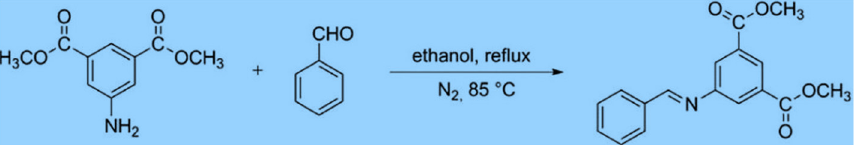
Figure 9. Synthesis route of 5-(benzylidene-amino)-isophthalic acid dimethyl ester (BA).